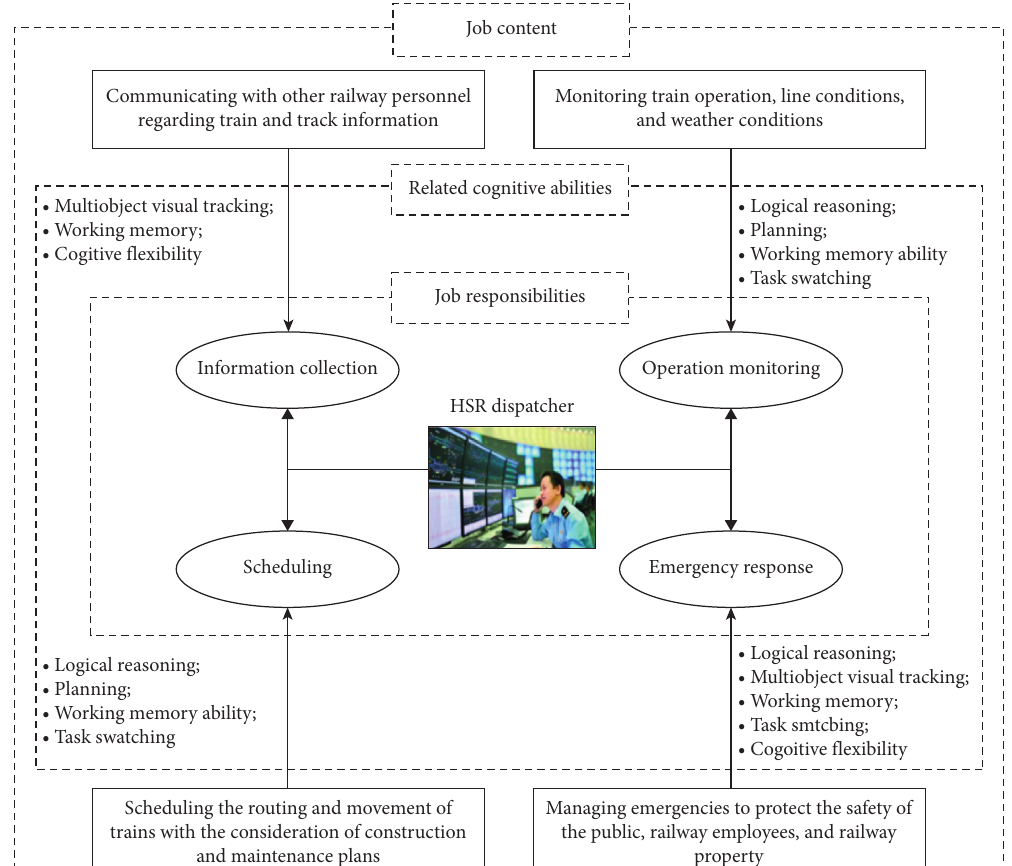
Figure 1: Chinese HSR dispatchers’ job responsibilities and related cognitive